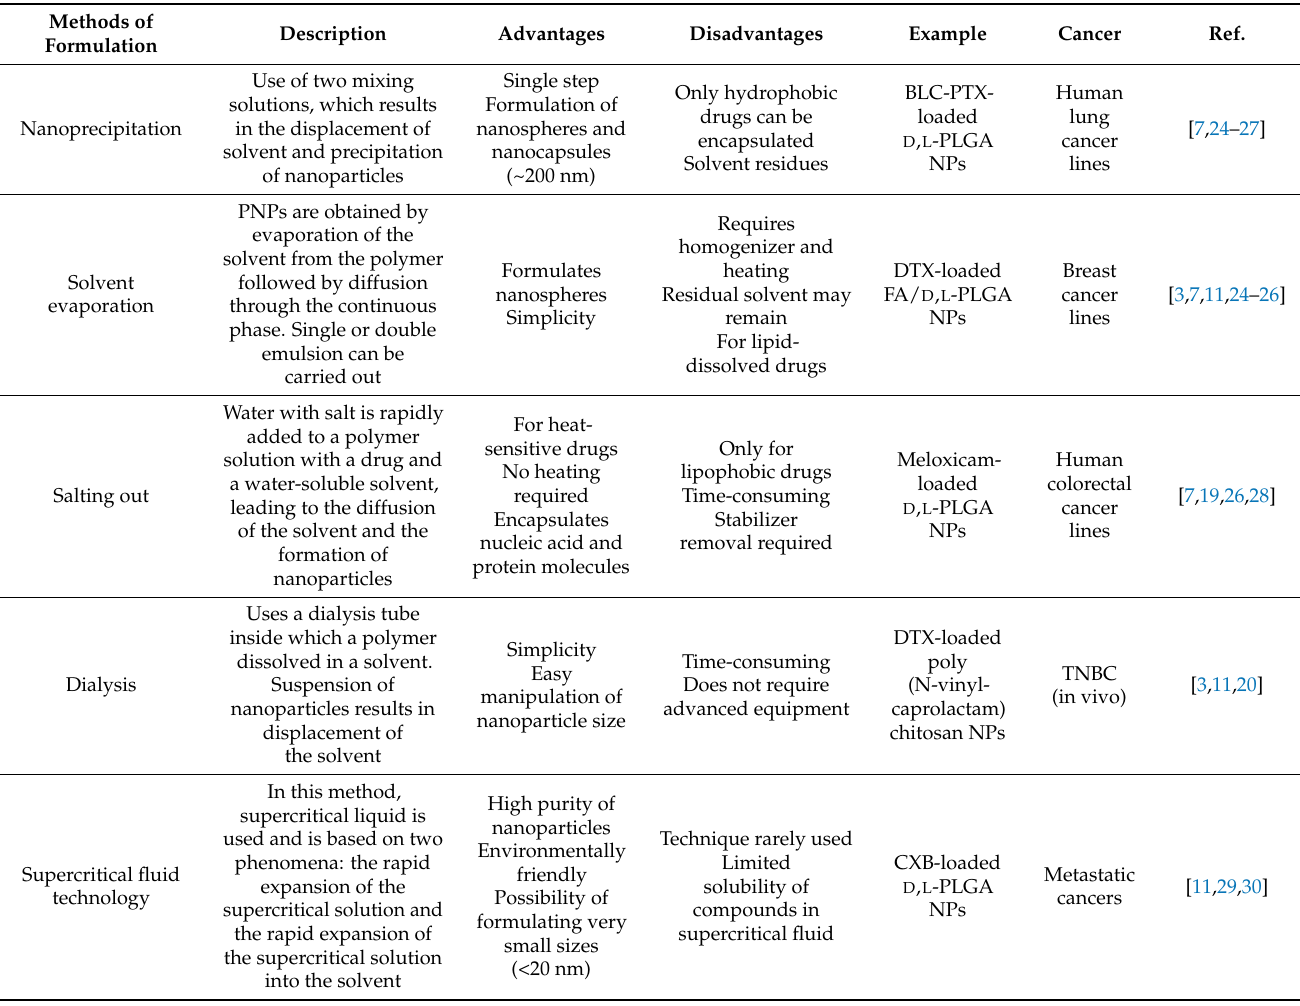
Table 2. Top-down techniques for formulation of polymeric